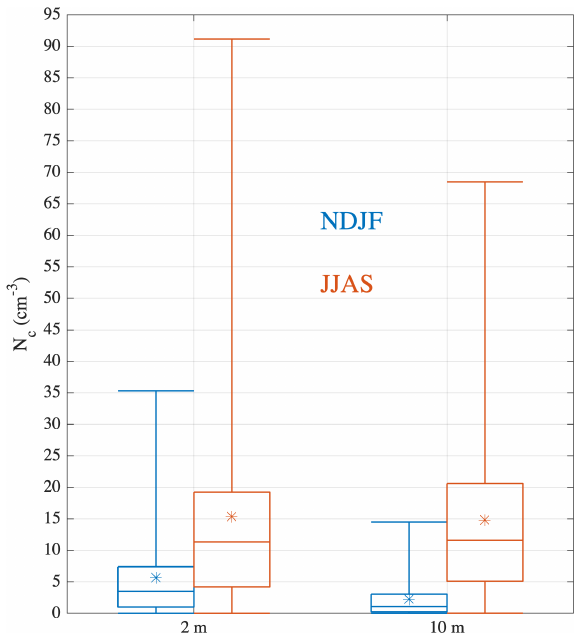
Figure 11. Box and whisker plots ( ∗ = mean, boxes are 25th, 50th, and 75th percentiles, whiskers are 1st and 99th percentiles) for all observations at times when both probes were operational in winter (NDJF, blue) and summer (JJAS, red) at 2 and 10m.